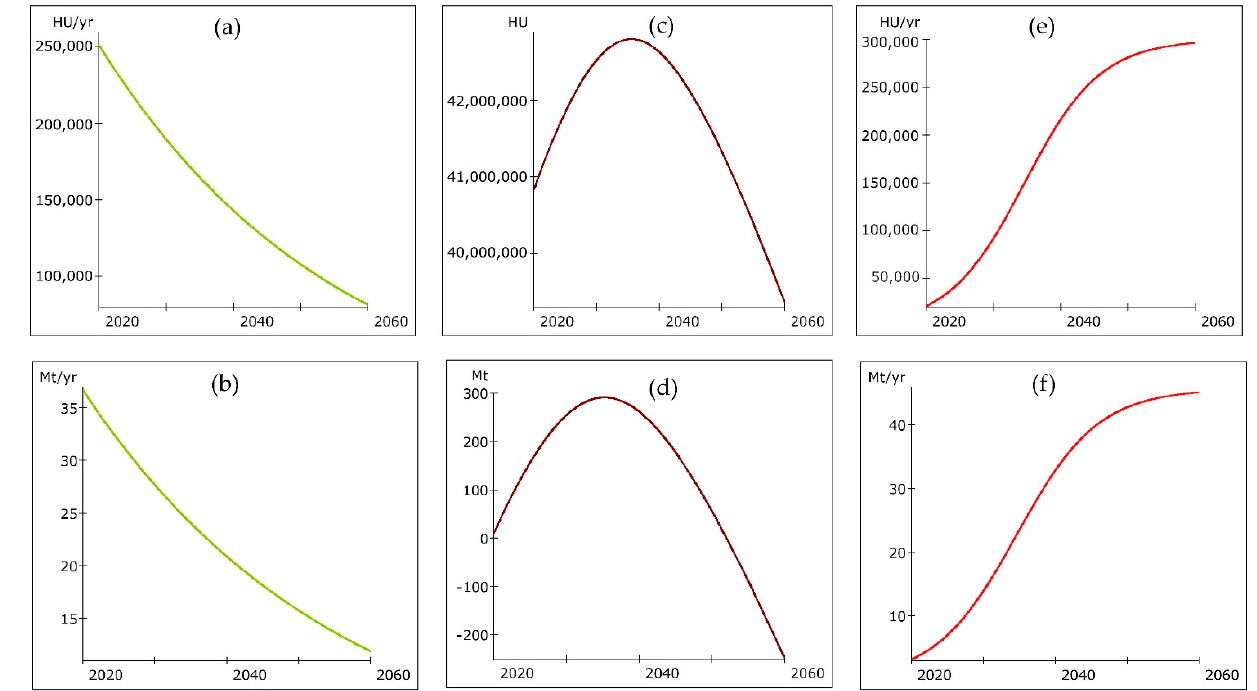
Figure 2. Activities in the German residential building sector from 2020 to 2060 shown by the evolution ( a ) of the ‘construction’ measured in housing units per year (HU/yr); ( b ) of the related ‘concrete mass for construction’ measured in mega tons per year (Mt/yr); ( c ) of the housing unit stock measured in housing units (HU); ( d ) of the ‘net stock change’ of construction material measured in mega tons (Mt); ( e ) of the ‘deconstruction’ measured in housing units per year (HU/yr); ( f ) of the related ‘deconstruction mass’ measured in mega tons per year (Mt/yr).